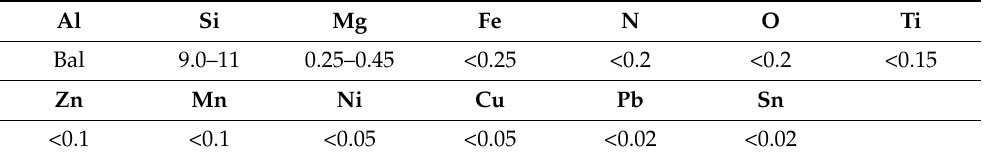
Table 1. Chemical composition of AlSi10Mg alloy powder (wt.%).